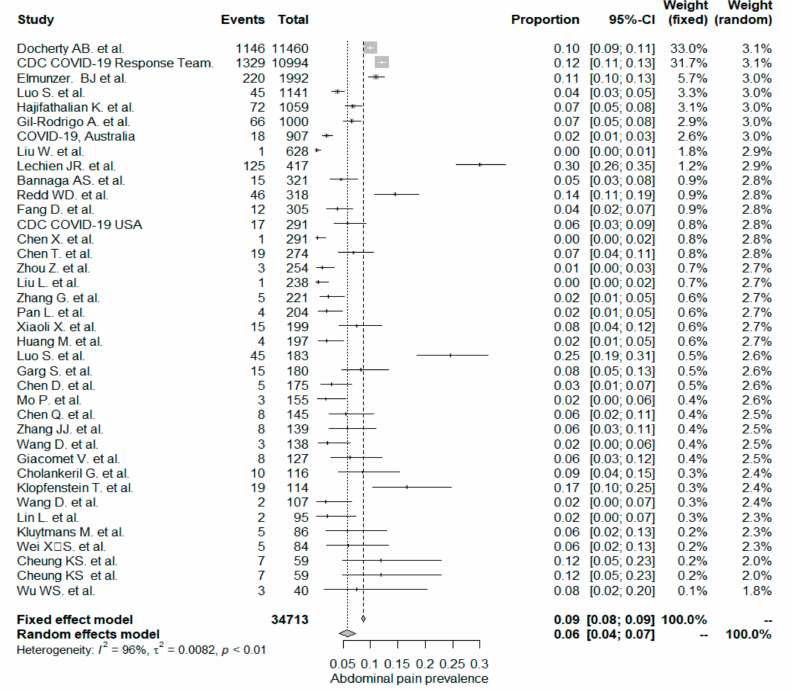
Figure 4. All studies, abdominal pain / discomfort forest plot and meta-analysis